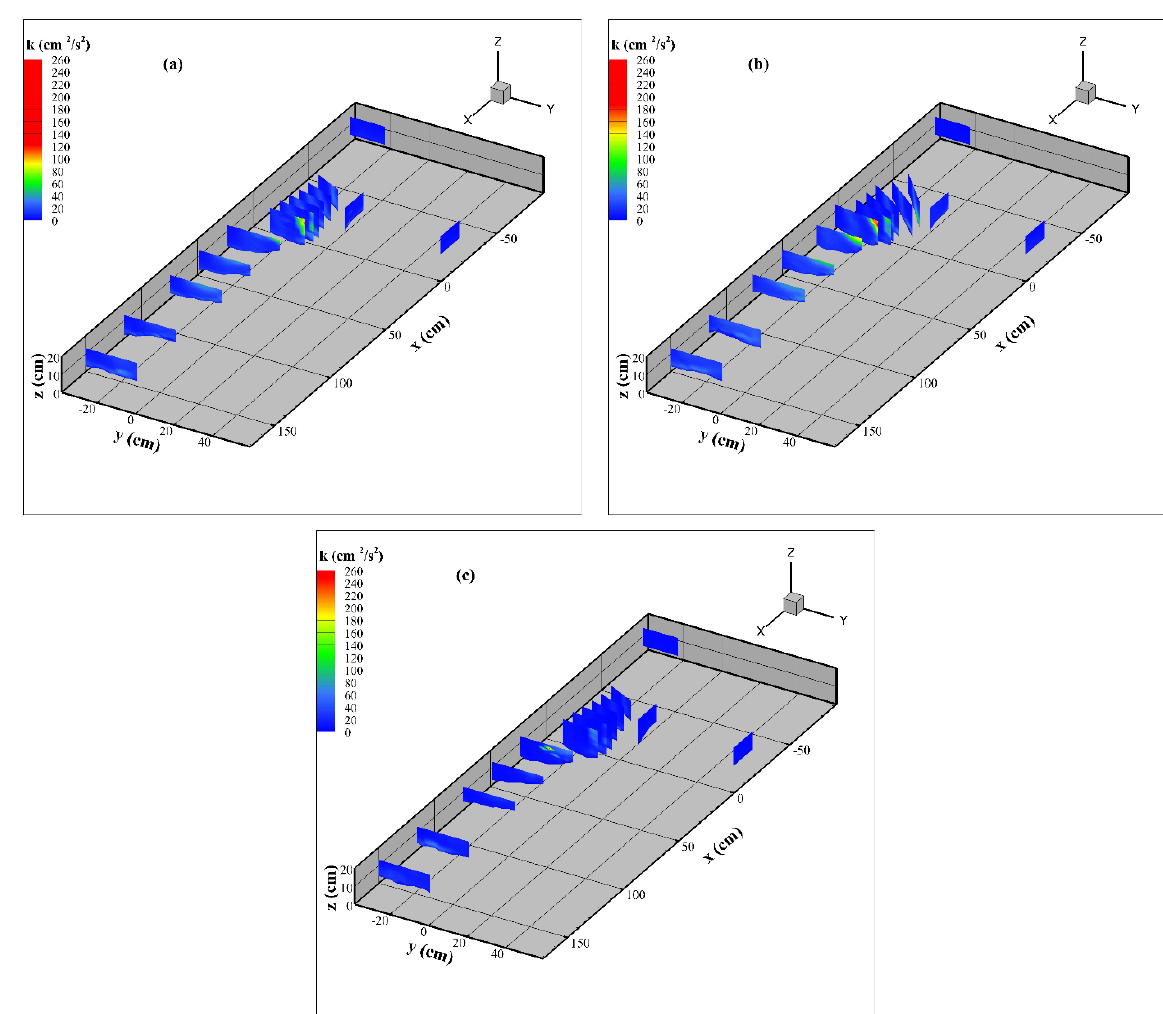
Figure 7. The spatial distribution of turbulent kinetic energy k of three cases. ( a ): case 1; ( b ): case 2; ( c ): case 3.